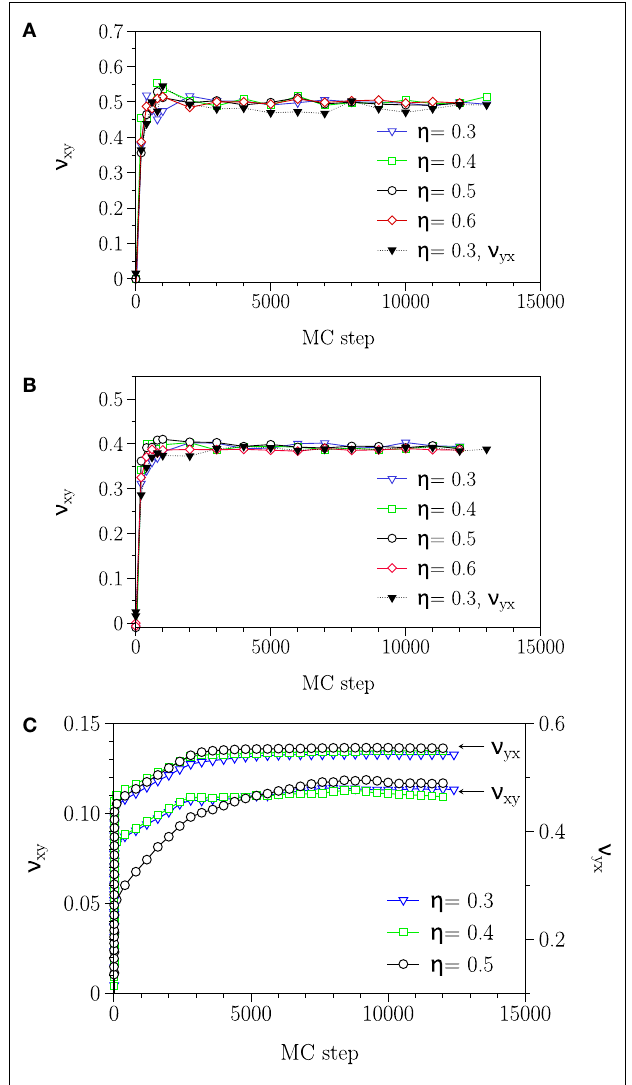
FIGURE 4 | Relaxation of − ∆ L i / η j L i in (A) fluid, (B) interdigitated, and (C) gel phase .The plateau value reached after about 5000 MC steps, independent of the value of η , yields the Poisson’s ratio ν . In the gel phase, Poisson’s ratio has different values for ν xy and ν yx and this phase acting as an anisotropic surface.